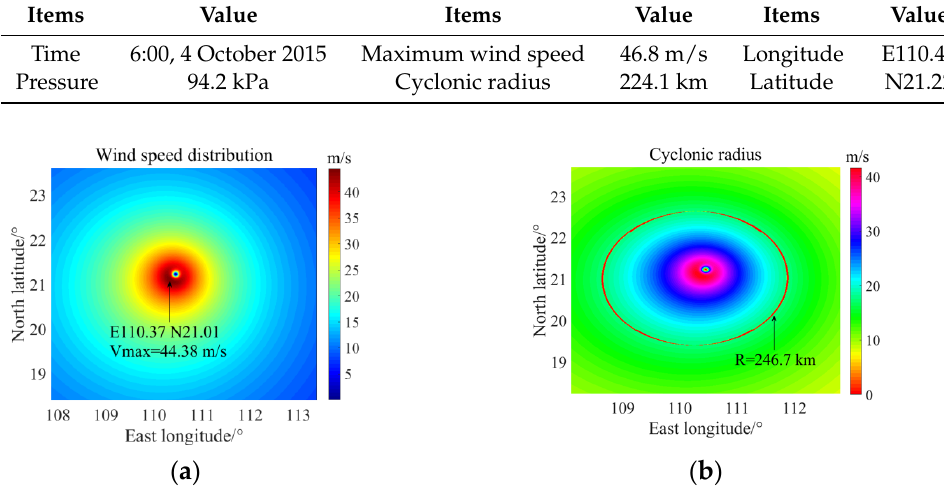
Figure 5. The simulation wind field: ( a ) Wind speed distribution; ( b ) Cyclonic radius.